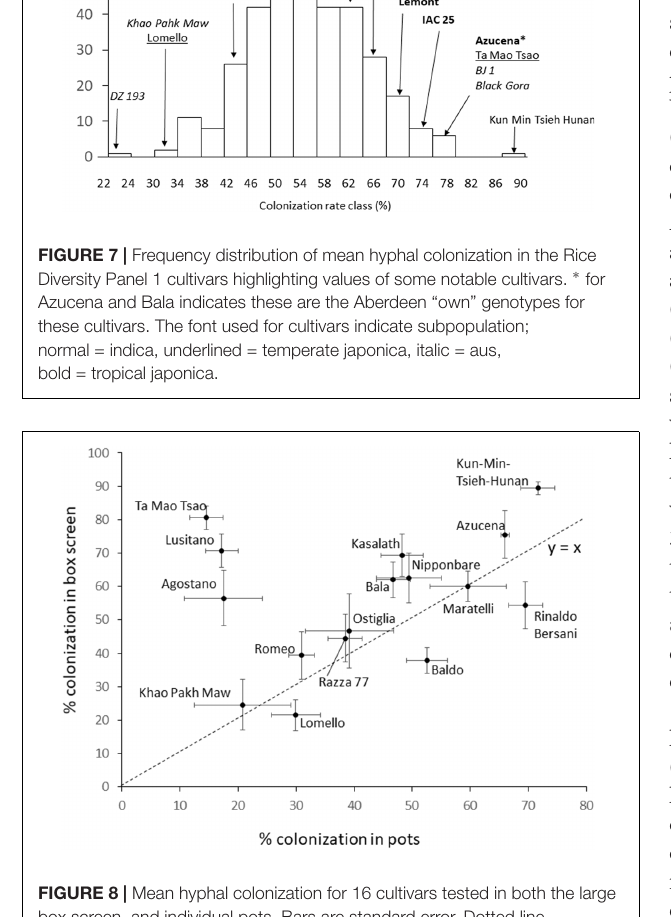
FIGURE 8 | Mean hyphal colonization for 16 cultivars tested in both the large box screen, and individual pots. Bars are standard error. Dotted line is the 1:1